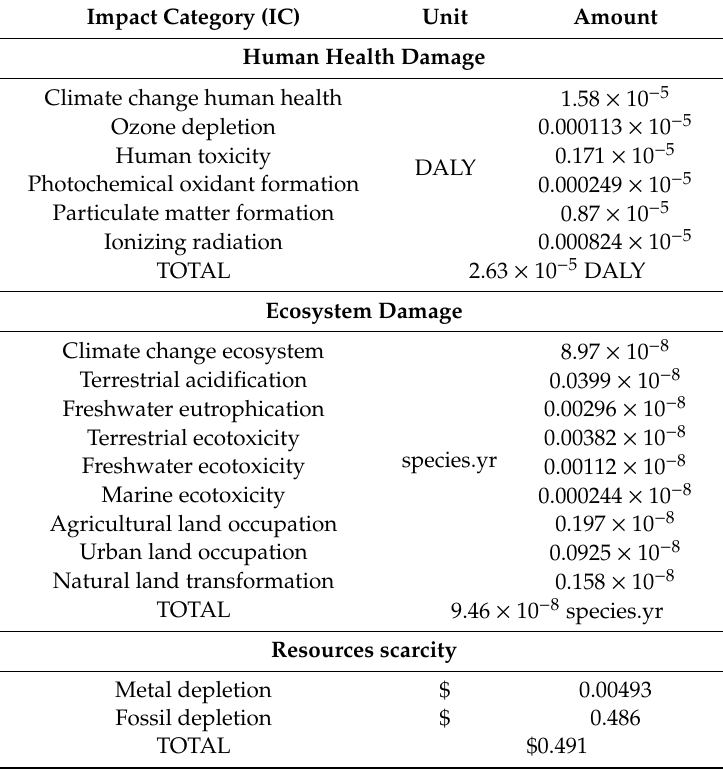
Table 2. Damage assessment by damage category and its respective impact categories analyzed using World ReCiPe End Point (H), excluding long-term emissions.